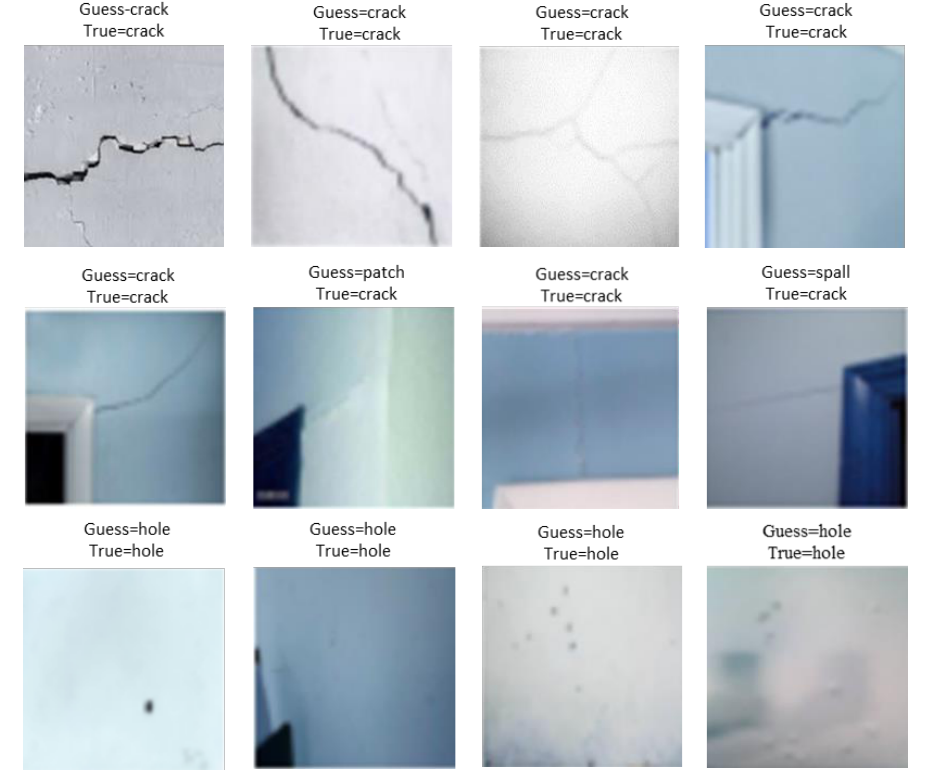
Figure 8. Prediction of wall defects by Conv2D Xception model.